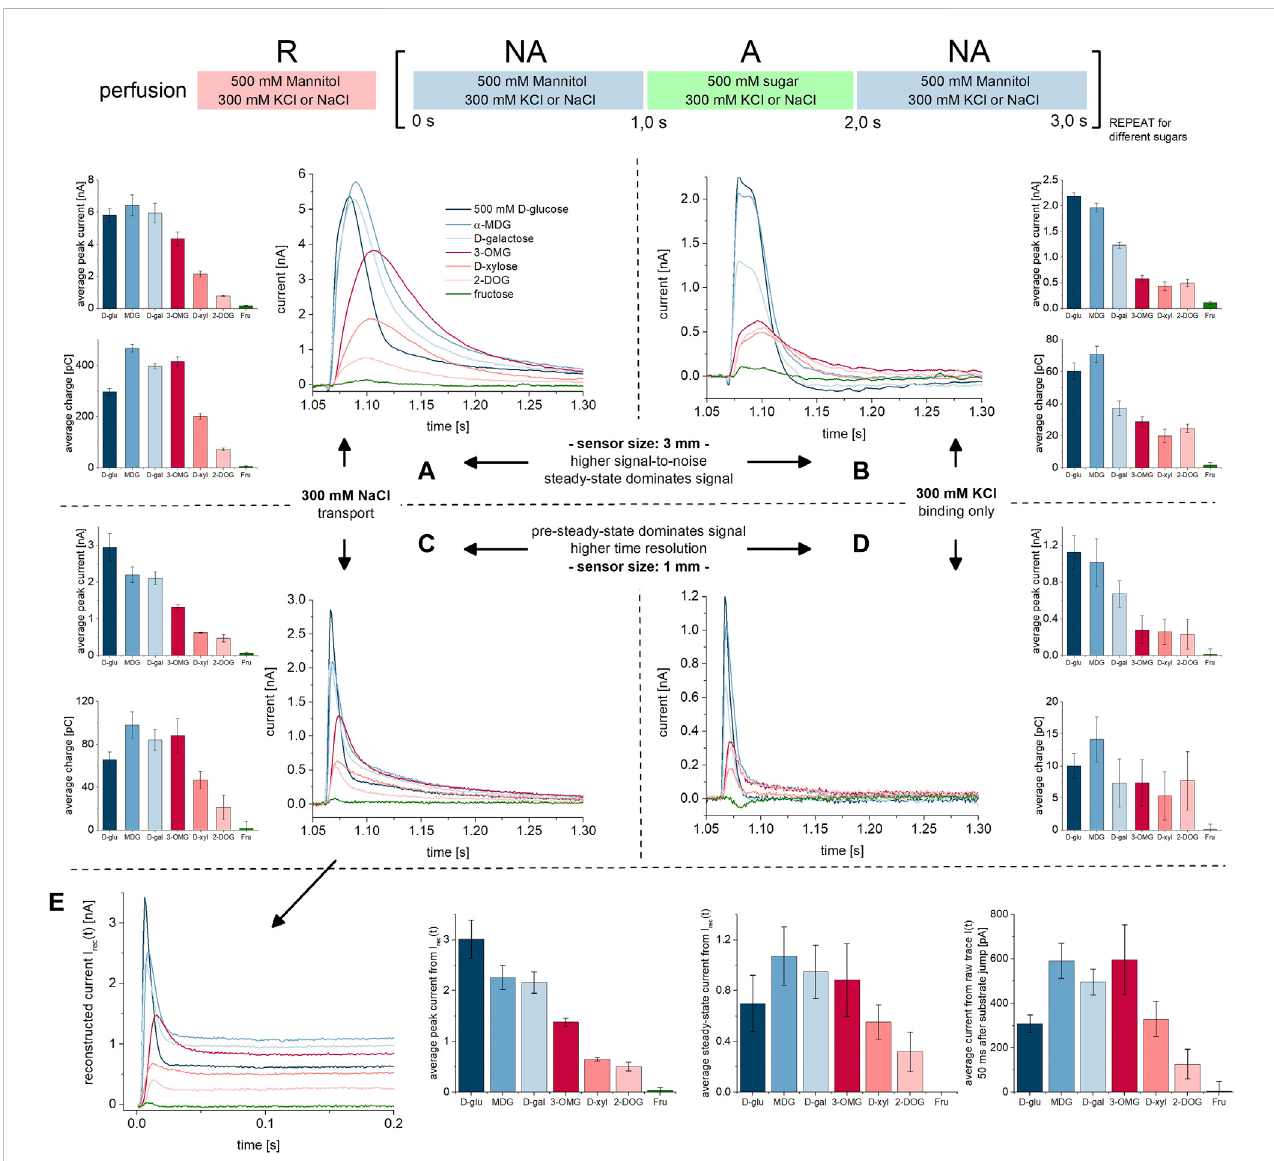
FIGURE 6 Na + /sugar transport and PSS current traces for different sugar substrates. All current traces were recorded at pH 7.4, either in the presence of 300 mM Na + (left) or 300 mM K + (right) in all measurement solutions and upon 500 mM concentration jumps of different sugars. We have compared the current traces recorded on 3 mm sensors (top) and 1 mm sensors (bottom). At given conditions, all sugar-induced traces were recorded on the same sensor. As a negative control D-fructose was used (green traces), which is not a substrate of SGLT1. The bar plots in (A – D) show averaged peak currents and charges (integrals) for all substrates under the given conditions and recorded from a total set of n = 3 sensors each. Standard deviations are a result of deviations across different sensors (no normalization was applied); the relative currents and charges between substrates are more accurate. The current traces shown are representative currents recorded from the same sensor. (A) Current traces recorded on 3 mm sensors in the presence of 300 mM Na + . The currents include transport and PSS current phases. From the right-shift of the peak current for OMG, D-xylose and DOG (red traces) we conclude that peaks are dominated by the transport current phase for the minor substrates. For D-glucose, MDG and D-galactose (blue traces) the fast PSS current phase dominates transport. (B) Current traces recorded on 3 mm sensors in the absence of Na + , which is replaced by 300 mM K + . The currents consist only of the PSS current phase resulting from sugar binding to the empty carrier. PSS current amplitudes are higher for the major substrates D-glucose, MDG and D-galactose, possibly due to a higher Q max , faster kinetics and/or higher af fi nity. (C) Sameexperimentasshownin(A)butrecordedon1 mmsensors.Incontrastto3 mmsensors,thePSScomponentispronouncedduetothehighertimeresolutionof the sensors. (D) Same experiment as shown in (B)but recorded on 1 mm sensors. The higher time resolution allows for conclusions about PSS kinetics. (E) Transporter currentswerereconstructedfromcurrentsshownin(C) via circuitanalysis(Tadini-BuoninsegniandFendler,2015).The fi rsttwo barplotsshowaveragepeakcurrentsand steady-state currents from the reconstructed transporter currents. Peak currents approximate the PSS currents. The third bar plot shows average currents 50 ms after substratejumpfromtherawcurrenttracesshownin(C),whichwasusedasapotentialread-outforthetransportcurrentandmostlymatcheswiththerelativechangeof the steady-state current from I rec